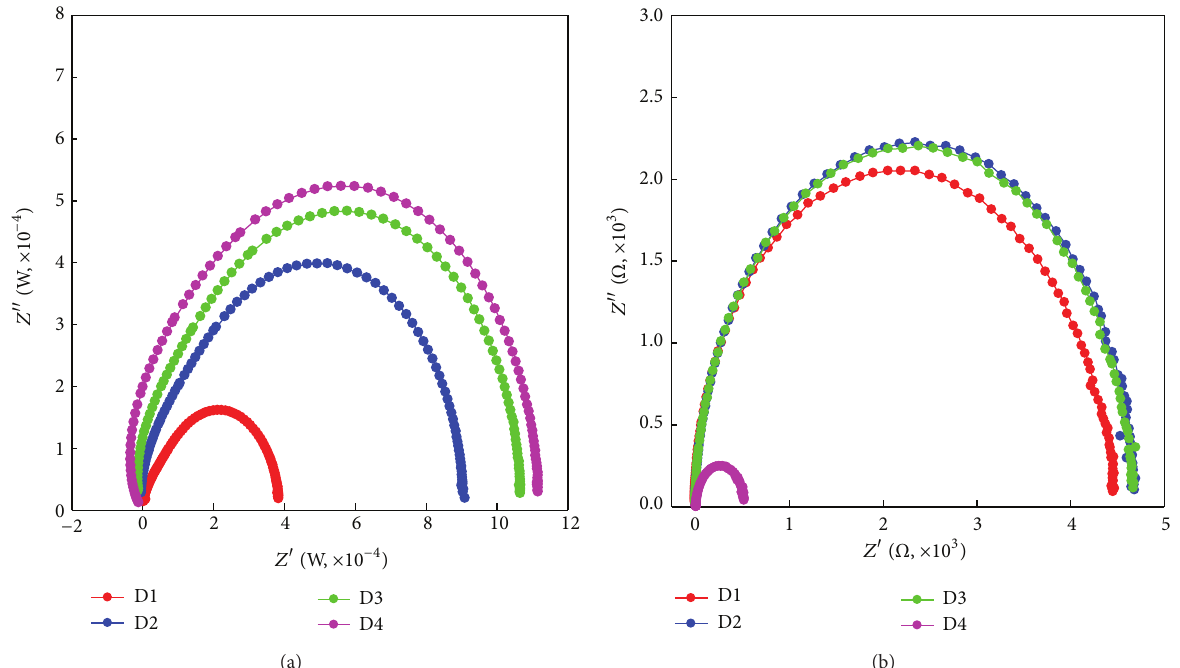
Figure 5: Intensity modulation photocurrent spectroscopy (IMPS) and intensity modulation photovoltage spectroscopy (IMVS) of chitosan sol-based DSSCs.